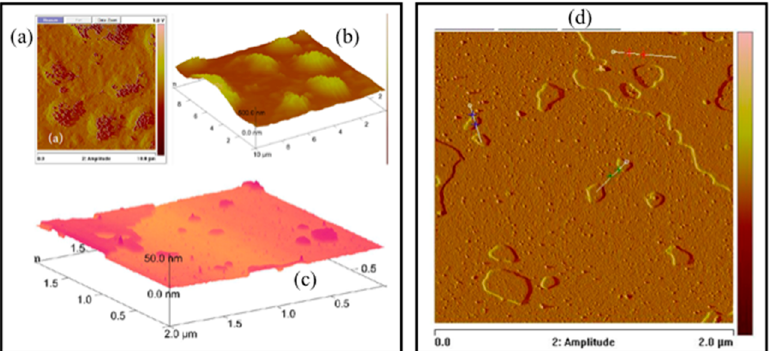
Figure 8. AFM (atomic force microscopy) micrographs of BS-HVL ( a – c ) and BC-HVL ( d ).